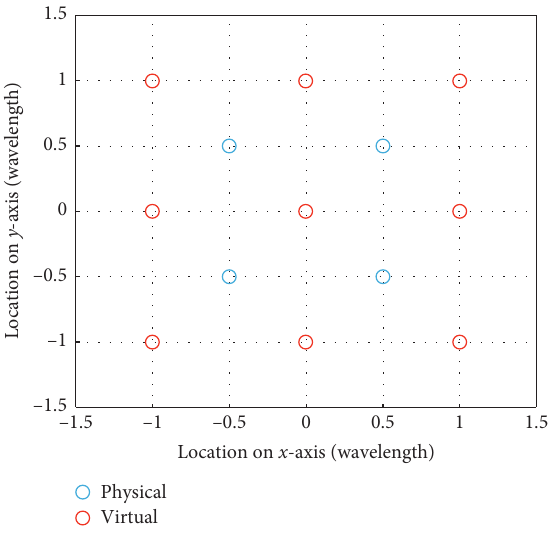
Figure 1: Virtual array